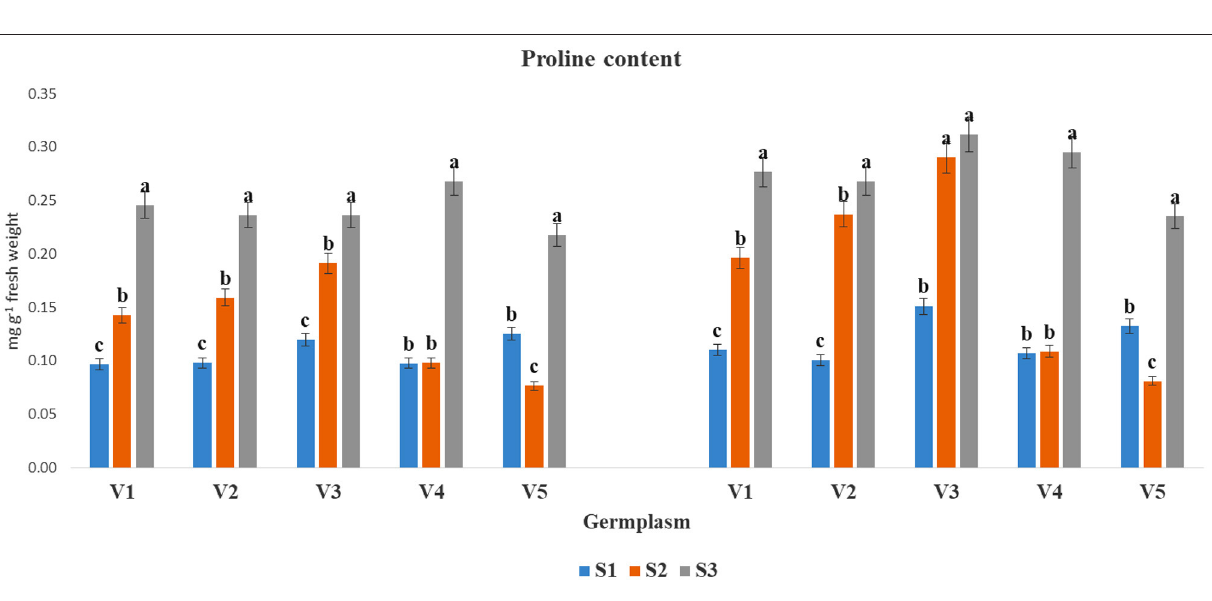
in three different dates has together accounted for 66.0